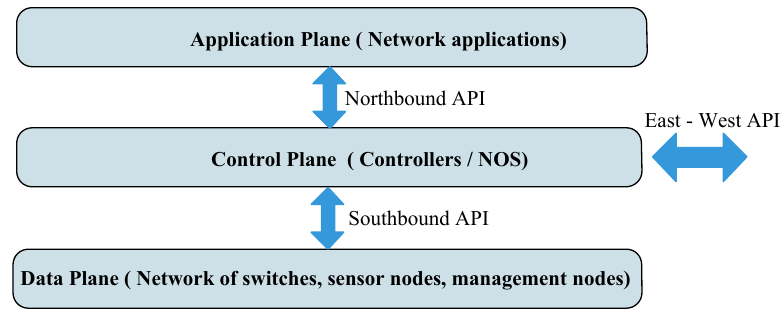
Figure 1. SDN overall